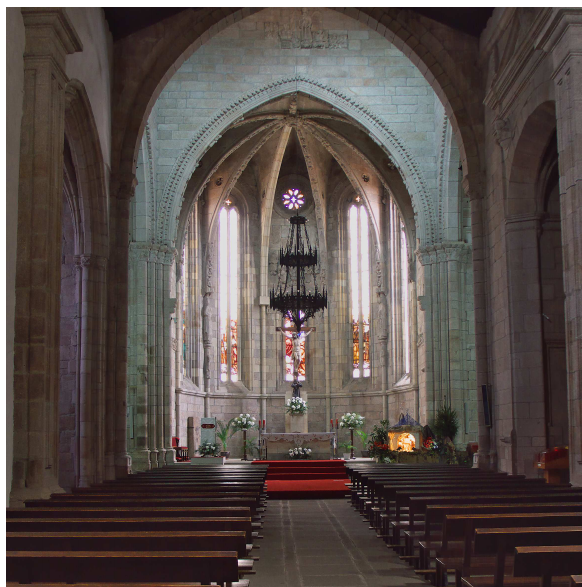
Figure 2. Interior view of San Francisco church.